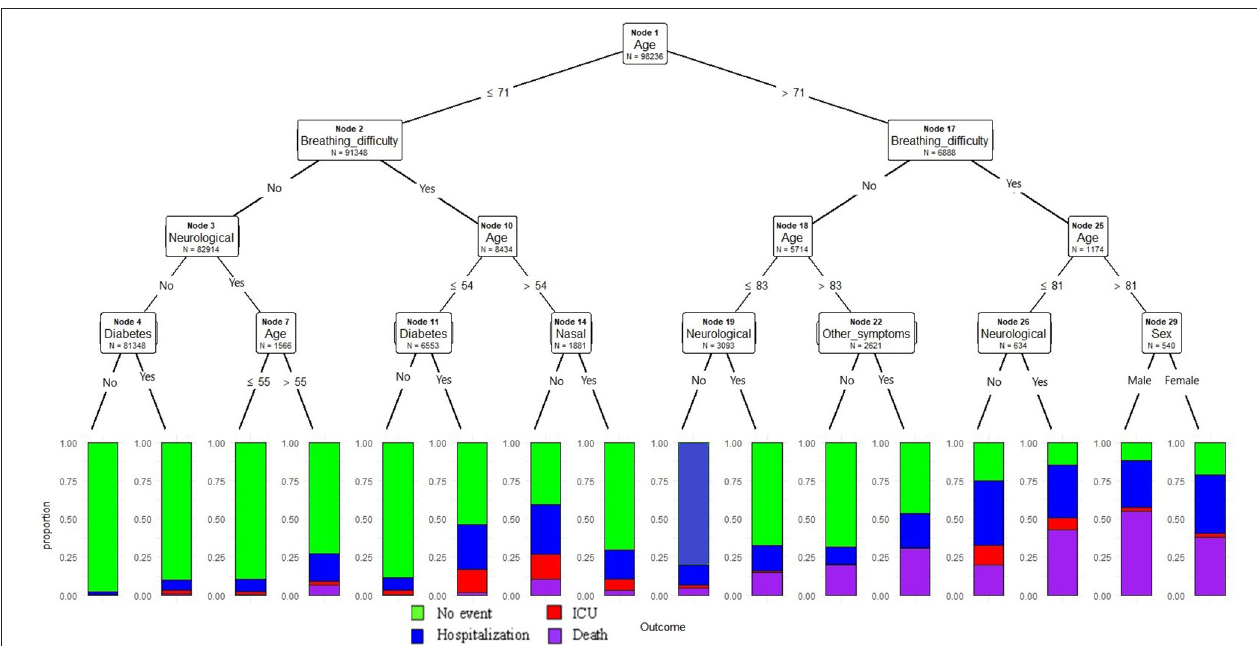
FIGURE 1 | Conditional inference decision tree for classifying severe outcomes (hospitalization, ICU admission death) among COVID-19 positive cases. The outcomes are described in color codes (green color- no hospitalization, ICU or death; blue- hospitalization only, no ICU or death; red- admitted to ICU, but no death; purple -death). The proportion of the events were plotted on the Y-axis at each node.